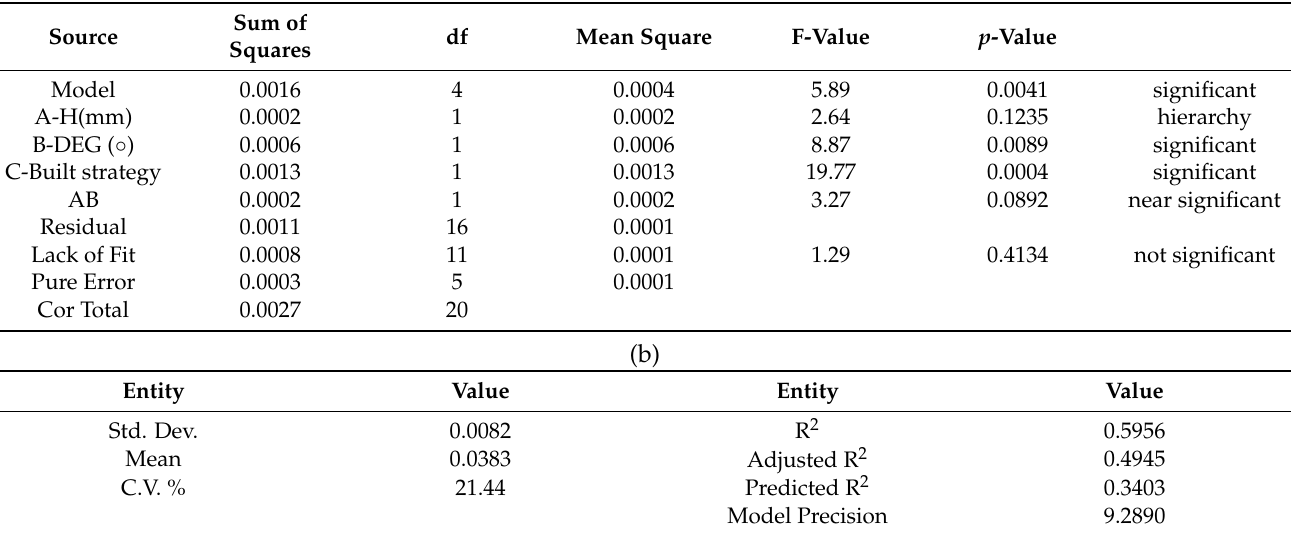
Table 5. (a) ANOVA output from for the impact strength analysis using a reduced 2FI model with a transformed response using the inverse square root transform. (b) Regression fitting parameters for the impact strength analysis using a reduced 2FI model with a transformed response using the inverse square root